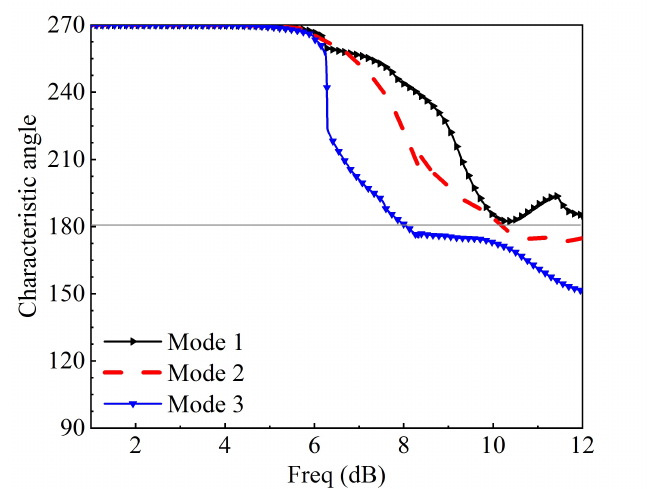
Figure 9. Characteristic angle curve of three modes at 10.6 GHz.